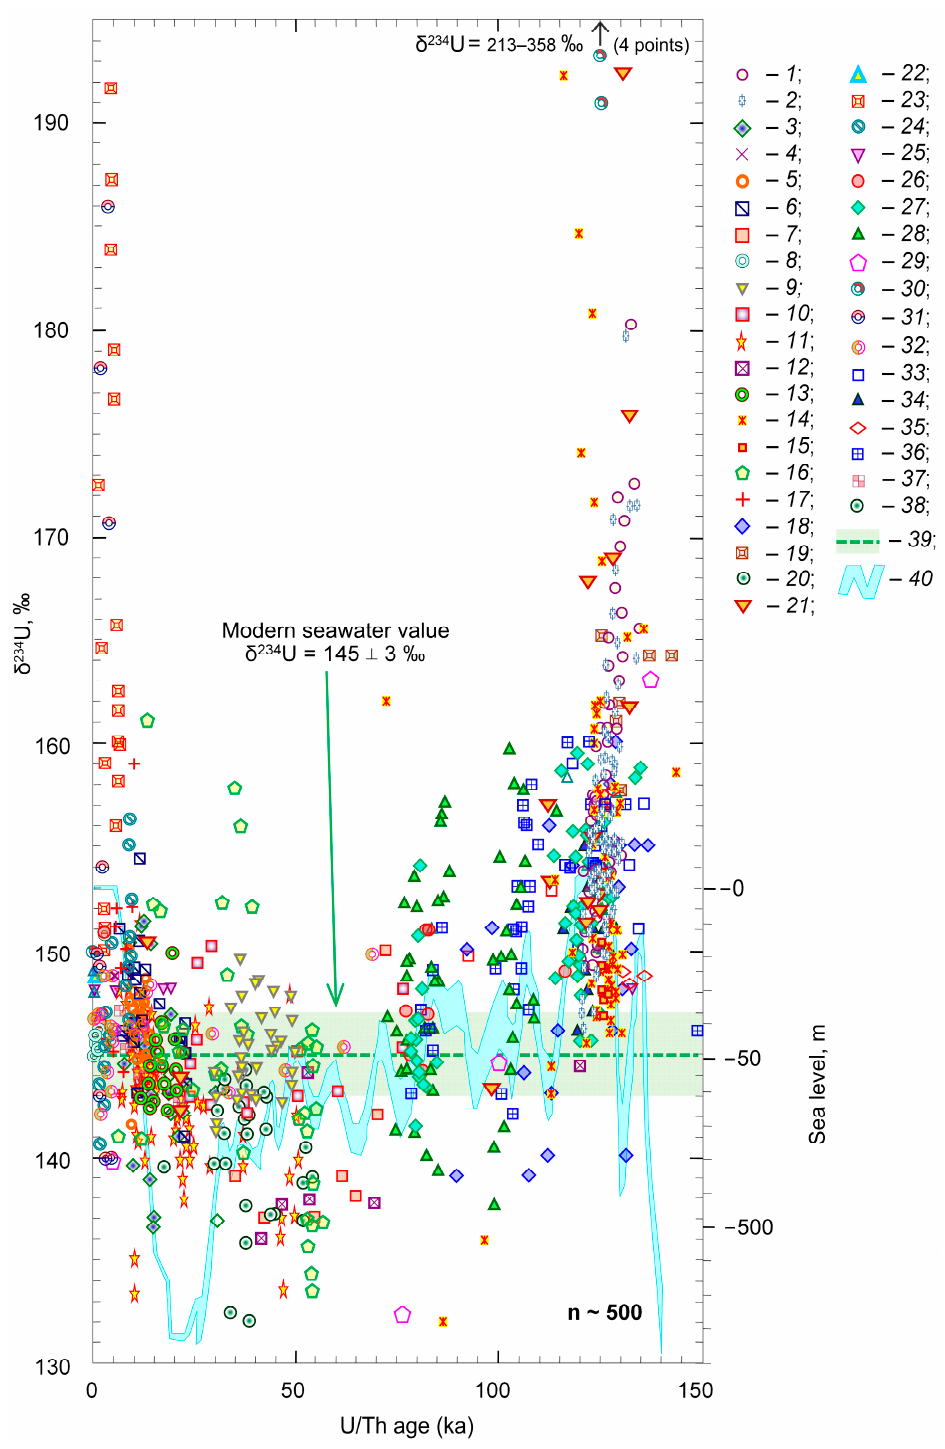
Figure 1. Initial uranium isotopic composition ( 234 U/ 238 U) in corals and carbonates of the circumpolar and arctic regions of